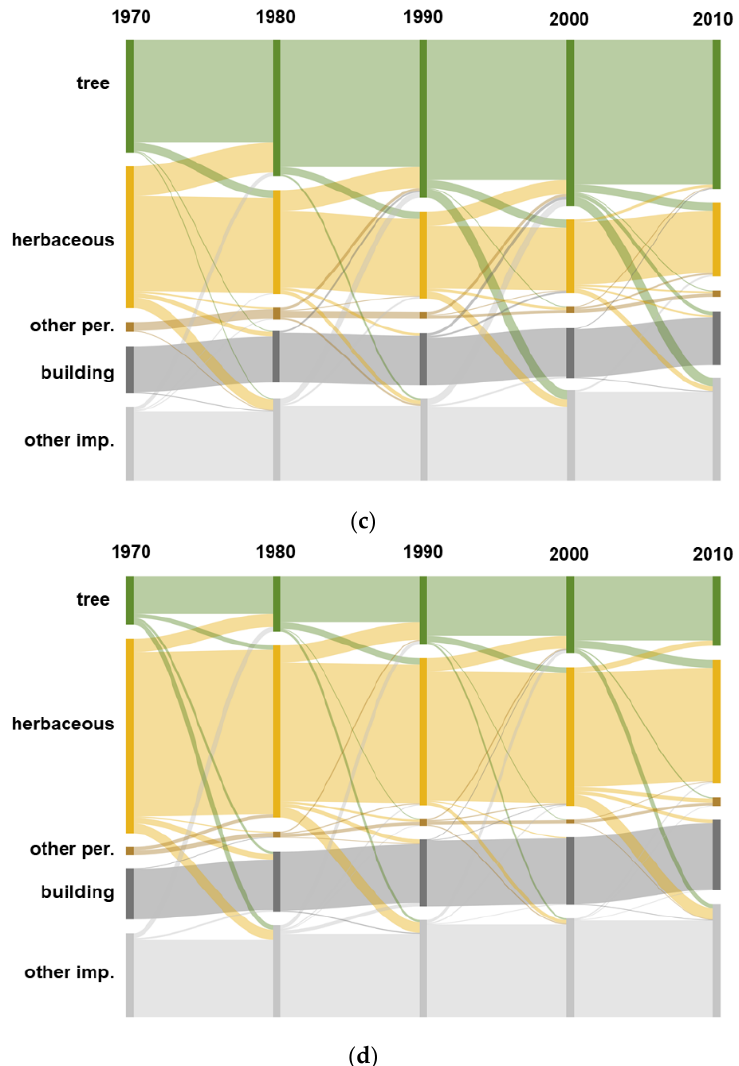
Figure 3. Sankey diagrams depicting transitions across land cover classes for the four planning districts with the largest net tree cover increases: ( a ) Lower North, ( b ) Lower Southwest, ( c ) Lower Far Northeast, and ( d ) Lower